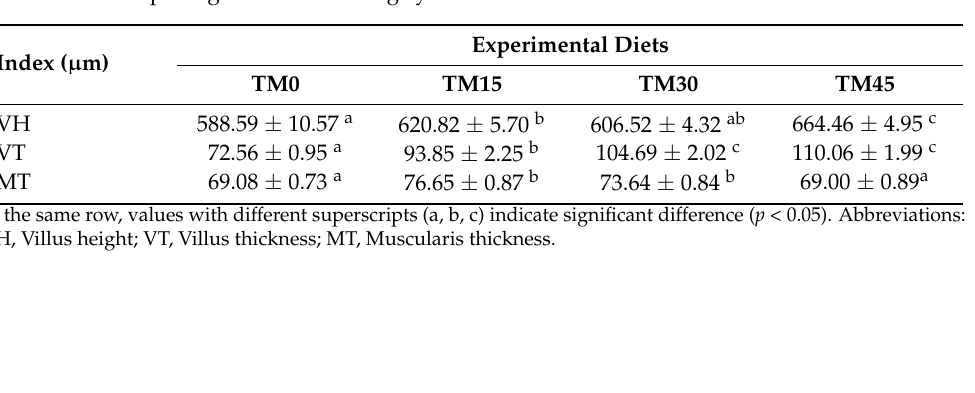
Figure 2. Observation of the gut morphology of large yellow croakers fed diets with different levels of TM ( Tenebrio molitor meal) by H and E staining (200 × ). Abbreviations: VH, Villus height; VT, Villus thickness; MT, Muscularis thickness. Table 6. Gut morphological indices of large yellow croakers fed diets with different levels of TM.